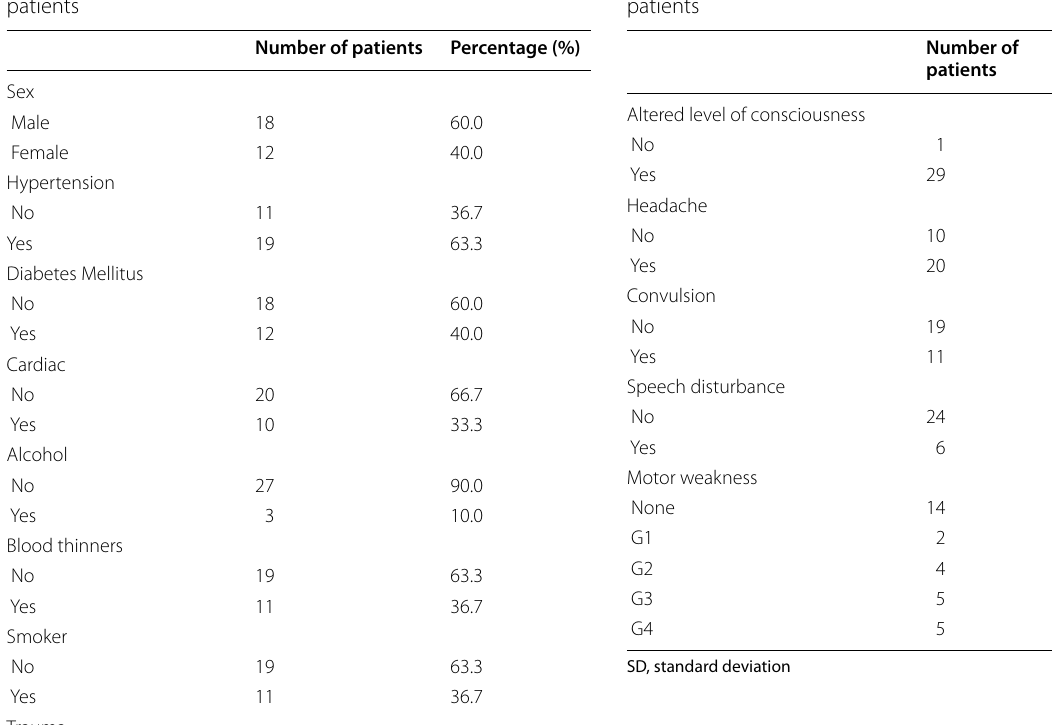
Table 2 Preoperative presenting symptoms of the studied